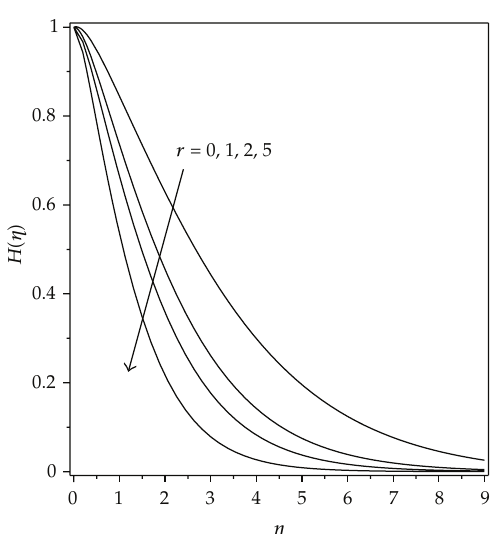
Figure 7: Concentration profiles for di ff erent values of r when Pr (cid:9) 0 . 78, Sc (cid:9) 0 . 6, D f (cid:9) 0 . 03, S r (cid:9) 2, M (cid:9) 1, and f 0 (cid:9) 0.